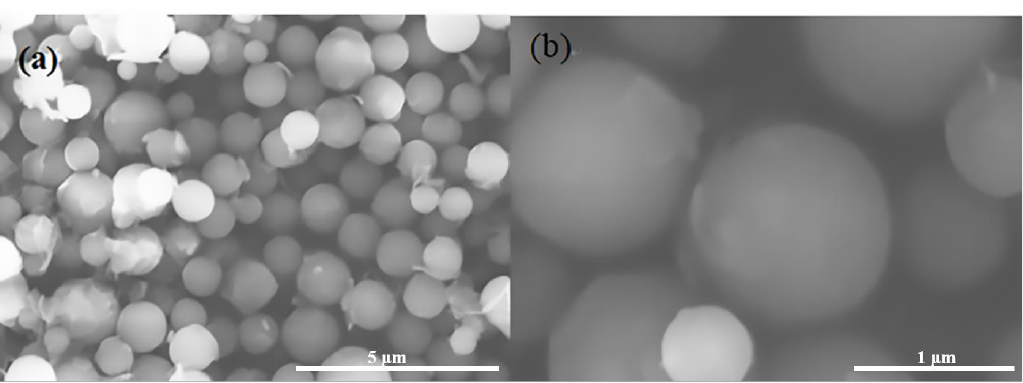
Figure 2. 15% P-SSCN imaged using scanning electron microscopy (SEM): ( a ) SEM images with a scale of 5 μm, ( b ) SEM images with a scale of 1 μm .